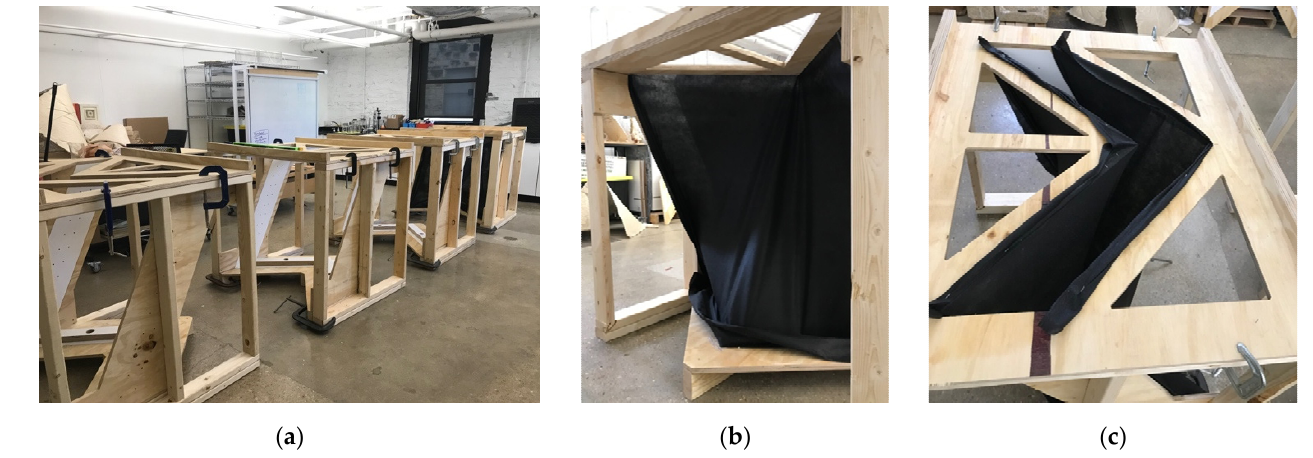
Figure 11. Fabric formwork apparatuses: ( a ) rigid elements of the apparatus composed of wood and plastic laminate sheet where there would be contact with living materials; ( b ) upholstered formwork with black synthetic geotextile fabric; ( c ) top of the formwork apparatus showing the geotextile upholstered into the rigid frame. Photos by the author.